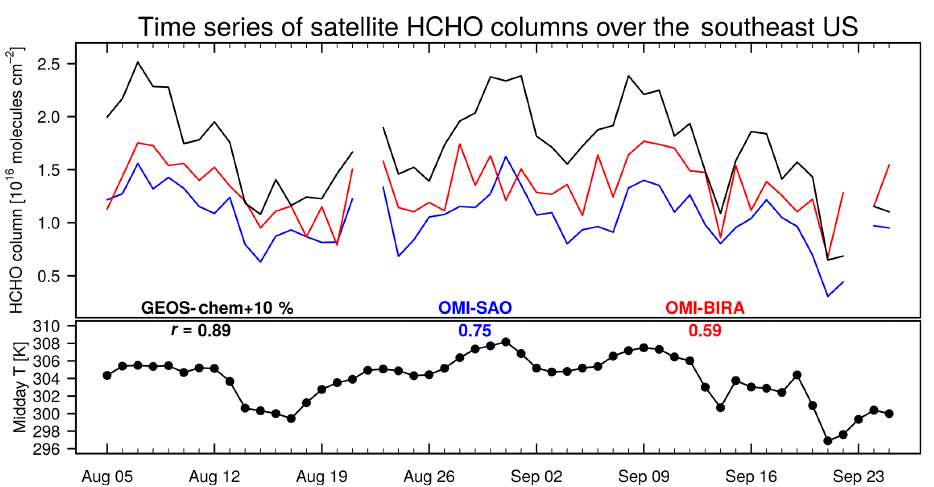
Figure 7. Daily variability of HCHO vertical column densities over the southeast US during SEAC 4 RS. The top panel shows daily HCHO columns averaged over the southeast US (box in Fig. 5) for the OMI-SAO and OMI-BIRA retrievals. GEOS-Chem columns (black) are sampled following the OMI viewing geometry with filtering by OMI-SAO quality flags and cloud conditions, and scaled up by 10% on the basis of comparison with CAMS aircraft columns. The bottom panel shows the local midday (12:00–13:00LT) surface air temperature over the southeast US domain from the GEOS-FP assimilated meteorological data. Also shown for each data set is the temporal correlation coefficient ( r ) with